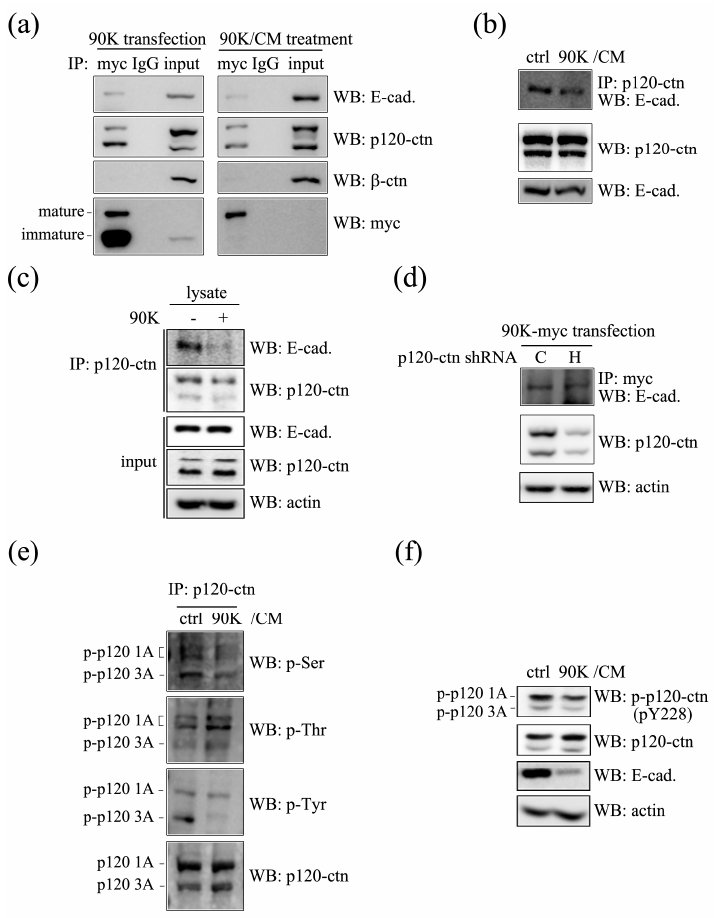
Figure 5. 90K interacts with E-cadherin, which affects the phosphorylation status of p120-catenin and thereby decreases the p120-catenin/E-cadherin association. ( a ) 90K was co-immunoprecipitated with E-cadherin and p120-catenin, but not with β -catenin. 293T cells were either transfected or treated with 90K (left panel) or 90K conditioned media (90K/CM) (right panel), followed by immunoprecipitation assay with an anti-myc antibody; ( b ) 90K/CM treatment decreased the interaction between p120-catenin and E-cadherin. 293T cells were treated with either ctrl/CM or 90K/CM for 16 h and immunoprecipitated with an anti-p120-catenin antibody; ( c ) Addition of 90K in 293T cell lysate decreased the interaction between p120-catenin and E-cadherin in vitro. Immunoprecipitation assay was performed by anti-p120-catenin antibody using 293T cell lysates added with or without 90K; ( d ) Knockdown of p120-catenin did not significantly affect the interaction between 90K and E-cadherin. 293T cells were transfected with 90K together with p120-catenin short hairpin RNA (shRNA), which is specific for either canine (C) or human (H) p120-catenin. The shRNA targeting canine p120-catenin, which cannot bind to human p120-catenin, was used as a negative control; ( e ) 90K/CM treatment affected the phosphorylation status of p120-catenin. 293T cells were treated with either ctrl/CM or 90K/CM for 16 h. p120-Catenin immuno-complex beads were followed by western blot analysis using antibodies against phospho-Ser, phospho-Thr, or phospho-Tyr; ( f ) 90K/CM treatment decreased phosphorylation of p120-catenin at Tyr-228 residue. 293T cells were treated with either ctrl/CM or 90K/CM for 16 h, and immunoblotted for phospho-Tyr-228-p120-catenin, p120-catenin, E-cadherin, and actin.